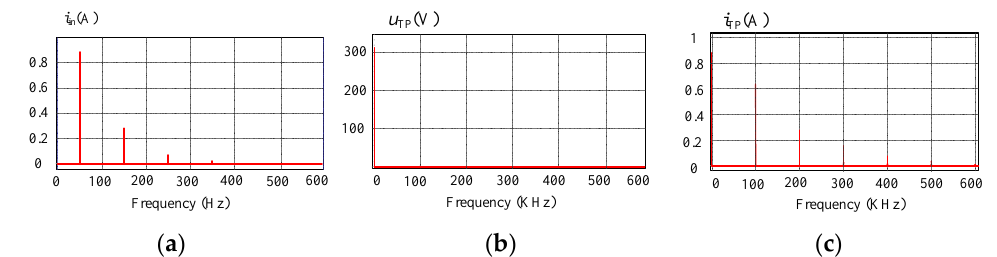
Figure 16. The frequency spectrum of the simulation waveforms. ( a ) The input current i in . ( b ) The input voltage u TP . ( c ) The input current i TP .